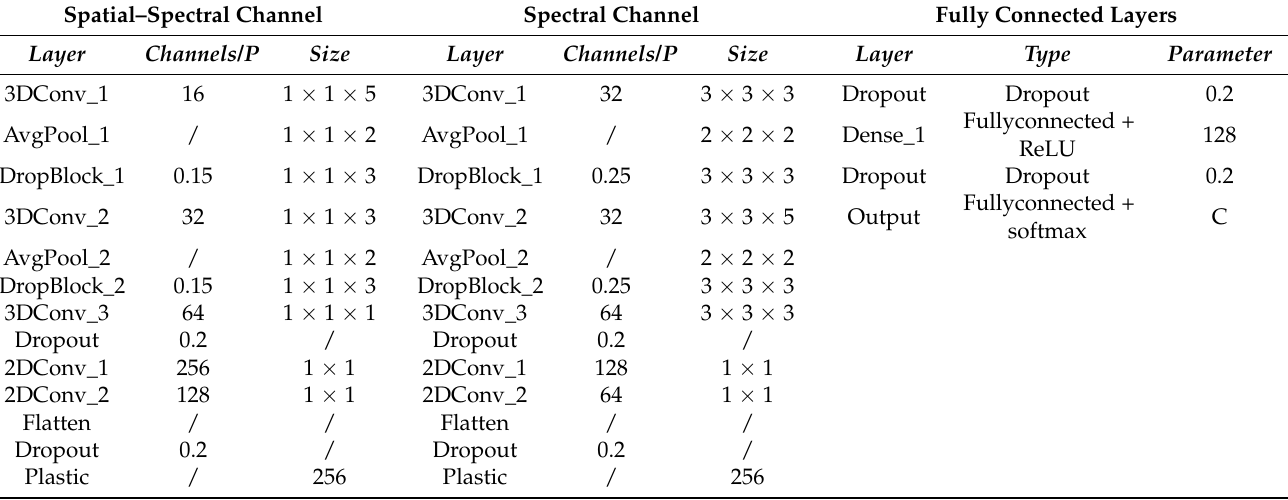
Table 1. Parameters of Spatial–Spectral channel, Spectral channel, and Fully connected layers.